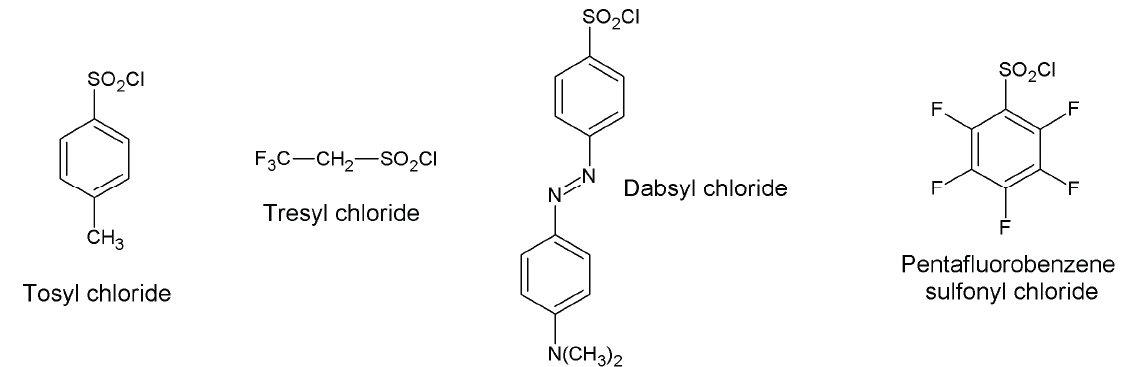
Figure 5. The most common sulfonyl halides used in protein